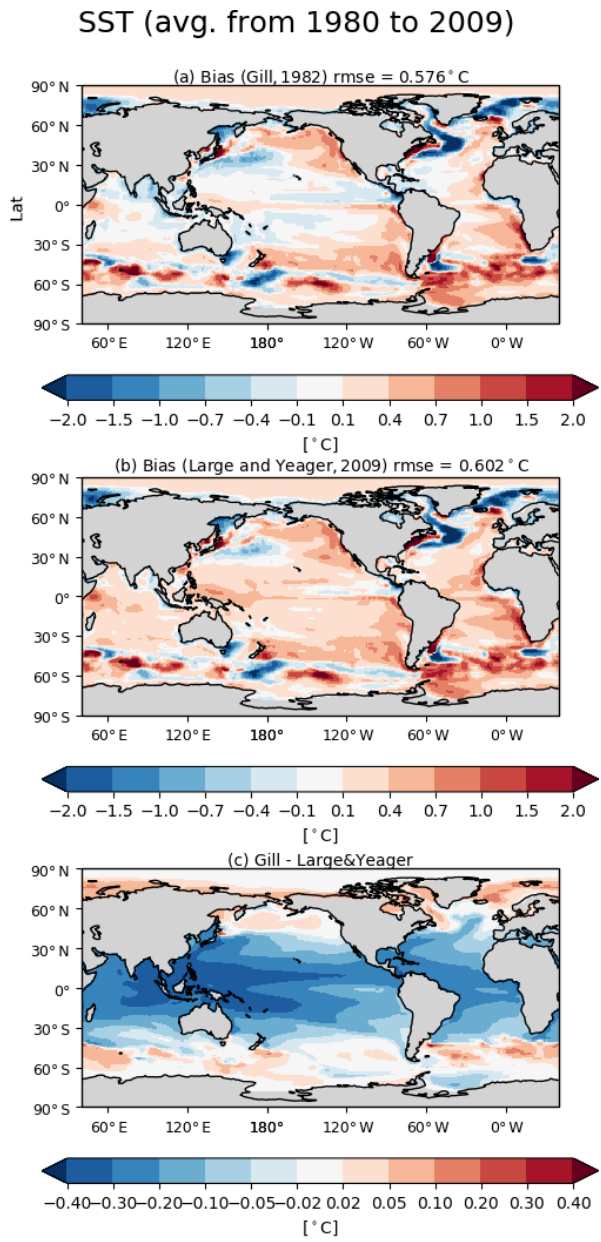
Figure B4. Panels (a) and (b) show the bias of 30-year (1980–2009) mean SST relative to PCMDI-SST of two OMIP-2 simulations by MRI.COM differing in the set of formulae for properties of moist air used to compute surface turbulent fluxes. (a) Gill (1982) and (b) Large and Yeager (2004, 2009). Panel (c) shows (a) minus (b) . Units are degrees Celsius ( ◦